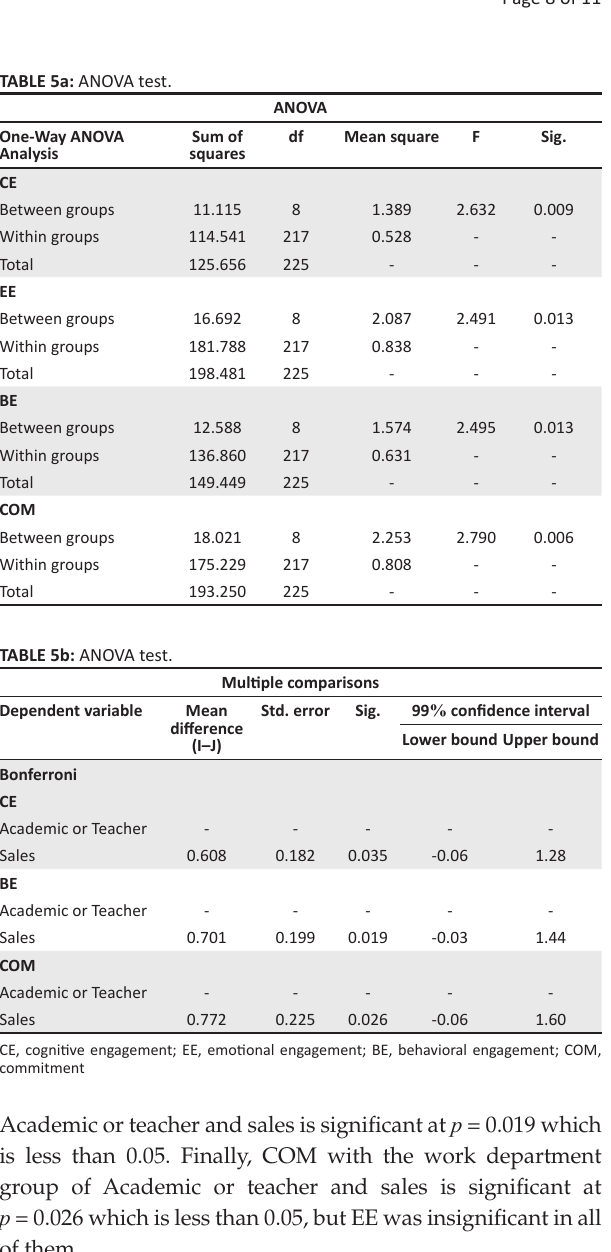
TABLE 5a: ANOVA test. One-Way ANOVA Analysis